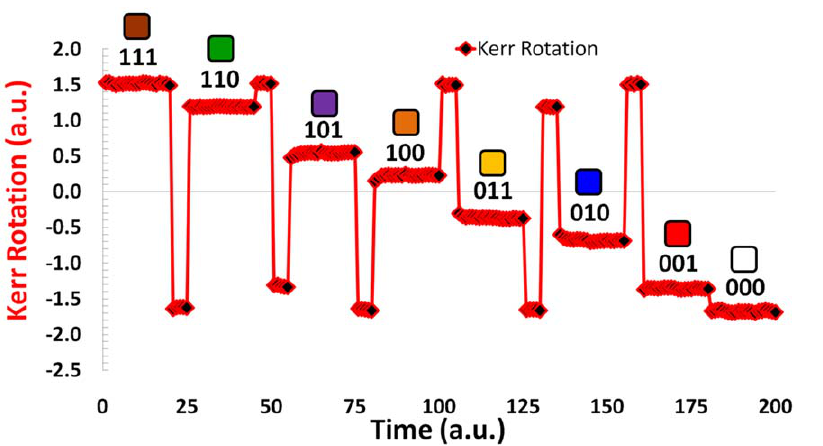
Figure 6. Kerr rotation measurement. The simultaneous Kerr rotation produced by the ML-3D media as a result of the externally applied magnetic fields. The binary representation for each level along with its color coding are listed above each of the eight magnetic states.